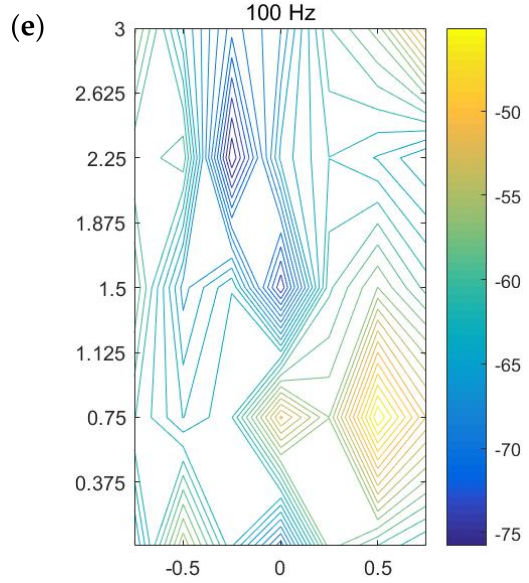
Figure 12. Magnitude contour images of ground surface vibration measurements at five Figure 12 . Magnitude contour images of ground surface vibration measurements at five frequencies.